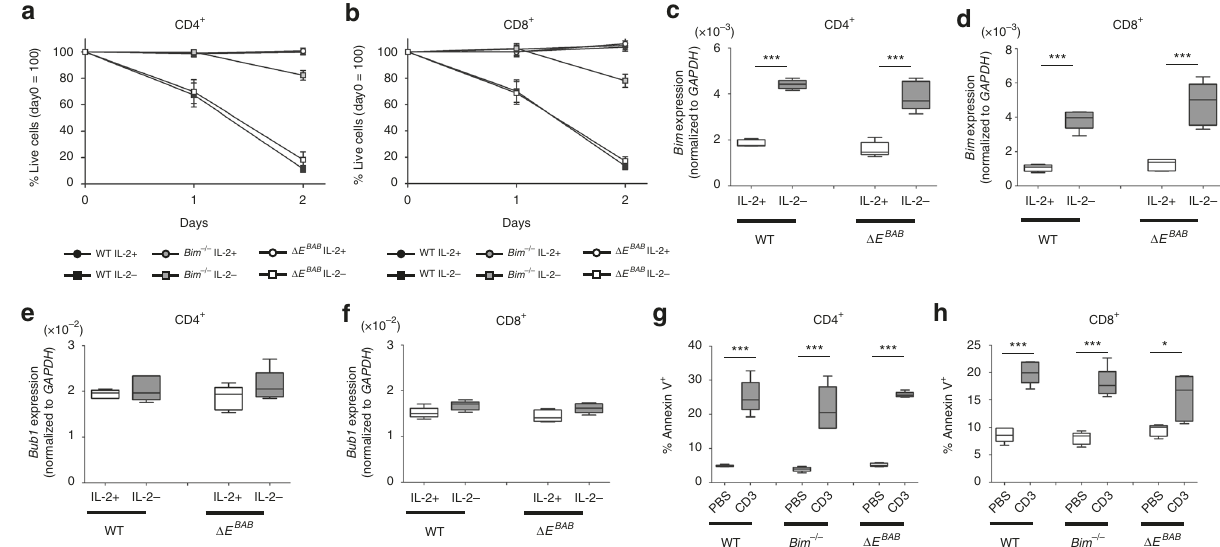
Fig. 7 E BAB is dispensable for two apoptotic pathways in peripheral T cells. a , b Viability (% Annexin V − PI − ) of activated CD4 + ( a ) and CD8 + ( b ) splenic T cells after IL-2 withdrawal. Data are pooled from ten independent experiments ( a ; n = 5 sex-matched WT – Δ E BAB pairs and n = 5 sex-matched WT – Bim − / − – Δ E BAB trios, 5 – 26 weeks old, mean ± s.d.) or 11 independent experiments ( b ; n = 5 sex-matched WT – Δ E BAB pairs and n = 5 sex-matched WT – Bim − / − – Δ E BAB trios, 5 – 26 weeks old, mean ± s.d.). c , d Gene expression level for Bim in activated CD4 + ( c ) and CD8 + ( d ) splenic T cells cultured with or without IL-2 for 6 h. Data are pooled from fi ve independent experiments ( n = 5 sex-matched WT – Bim − / − – Δ E BAB trios, 5 – 14 weeks old). e, f Expression of Bub1 in activated CD4 + ( e ) and CD8 + ( f ) splenic T cells cultured with or without IL-2 for 6 h. Data are pooled from fi ve independent experiments ( n = 5 sex- matched WT – Bim − / − – Δ E BAB trios, 5 – 14 weeks old). g , h Apoptotic cell rate (%Annexin V + ) of activated CD4 + ( g ) and CD8 + ( h ) splenic T cells restimulated with anti-CD3 antibody (5 µ g/ml) for 6 h. Data are pooled from fi ve independent experiments ( n = 5 sex-matched WT – Bim − / − – Δ E BAB trios, 5 – 26 weeks old). Edges of the box are the 25th and 75th percentiles, and error bars extend to the maximum and minimum. Outliers are de fi ned as the data point that is located outside of q 3 + 1.5( q 3 − q 1 ) and q 1 − 1.5( q 3 − q 1 ), in which q 1 and q 3 are the 25th and 75th percentiles ( c – h ). n.s. not signi fi cant ( P ≥ 0.05); * P < 0.05, ** P < 0.01, *** P < 0.001 (unpaired two-tailed Student ’ s t